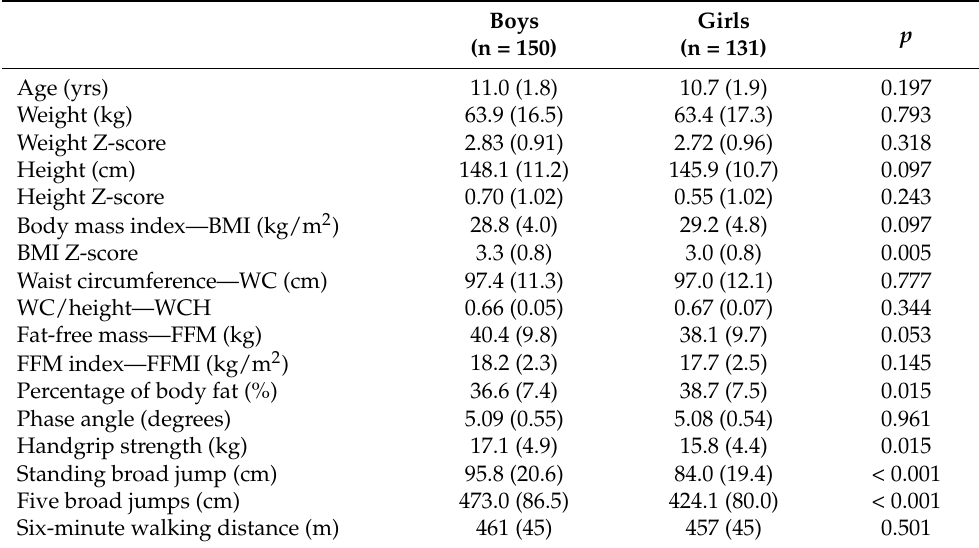
Table 1. General characteristics, body composition, BIA-derived phase angle, and physical fitness of the whole study